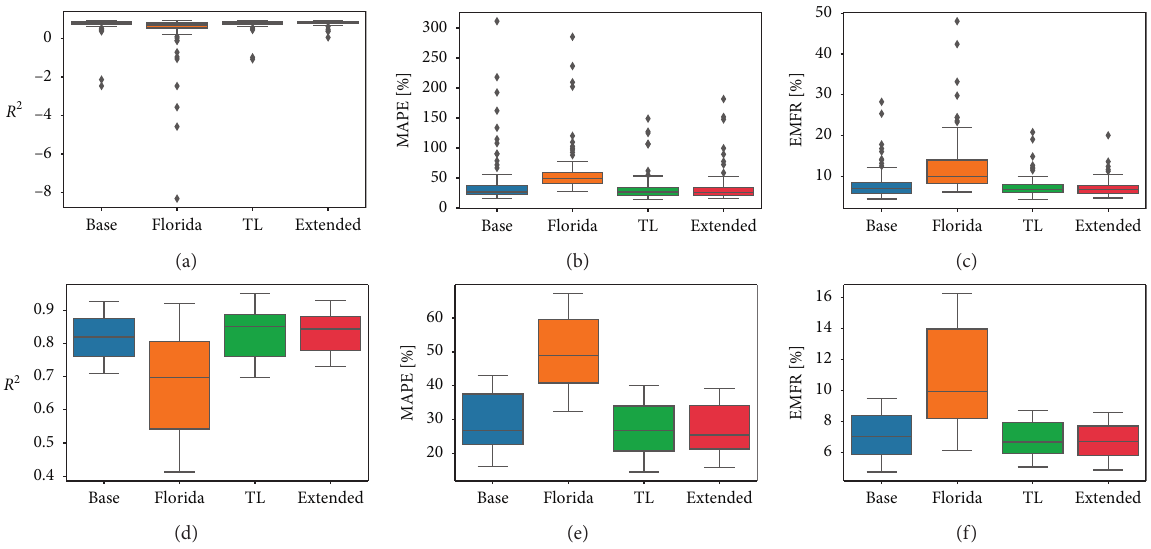
Figure 4: R 2 , MAPE, and EMFR metrics for different approaches with and without outliers. (a) R 2 with outliers, (b) MAPE with outliers, (c) EMFR with outliers, (d) R 2 without outliers, (e) MAPE without outliers, and (f) EMFR without outliers.